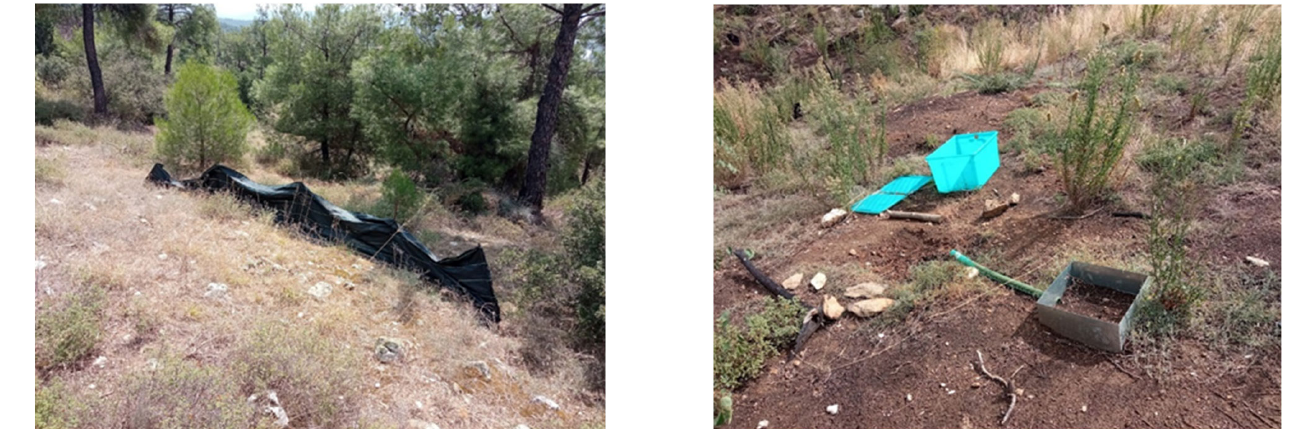
Figure 8. Silt fence which was damaged by humans trying to pullout the metal rebars and geotextile ( left ). Damage to the experimental setup for the measurement of runoff ( right ).